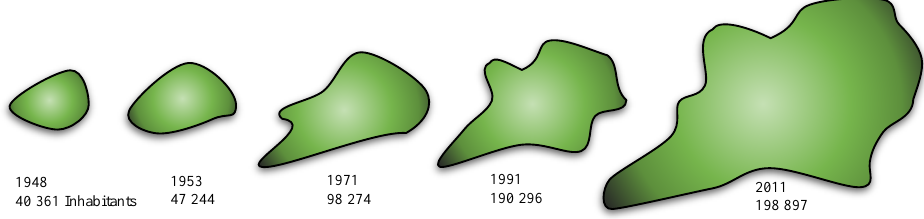
Fig. 1. Spatial changes of land morphology and demography through decades, the city of